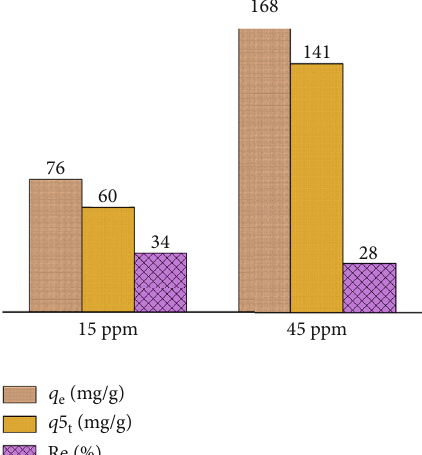
Figure 4: Graphical illustration of the adsorption of CV ( C and 45 ppm) on PACK after 5min ( q phase) and at equilibrium ( q